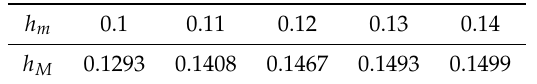
Table 4. Maximum bounds of h M for different h m by Proposition